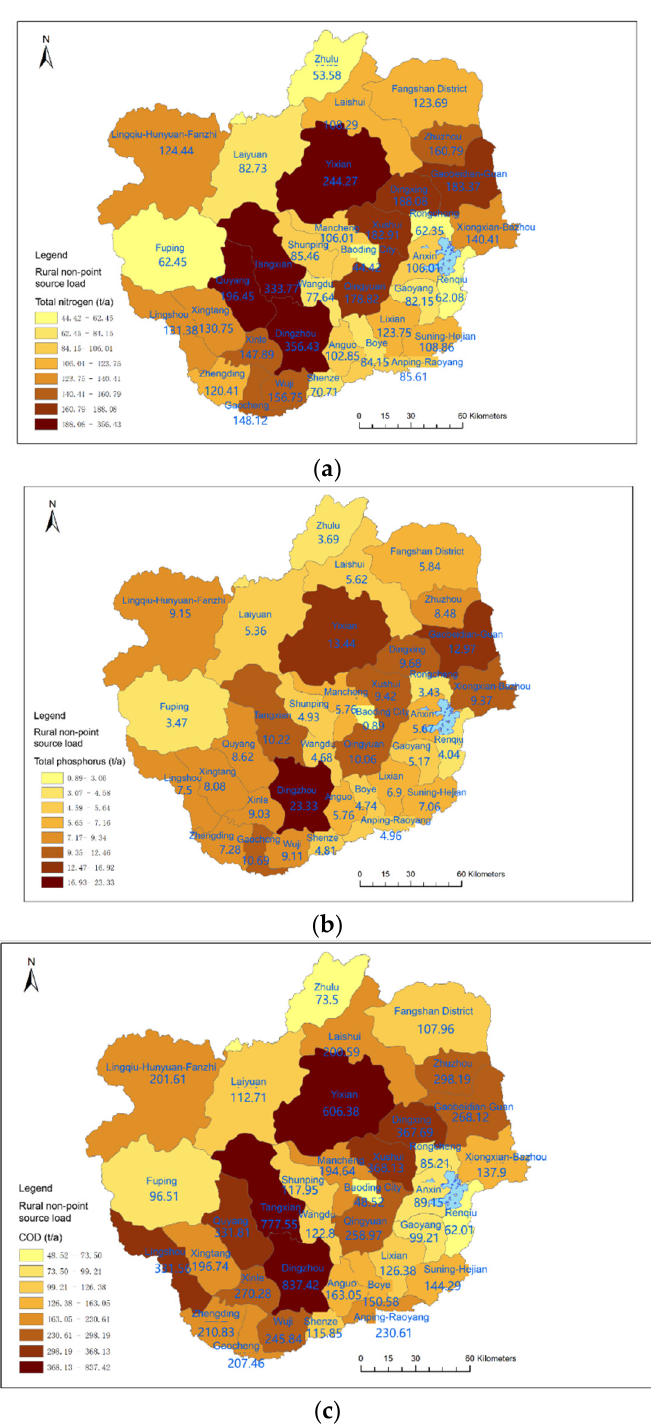
Figure 5. The total load of non-point source pollution in agriculture and rural areas in Baiyangdian lake: ( a ) Total nitrogen load, ( b ) Total phosphorus load, ( c ) COD load.